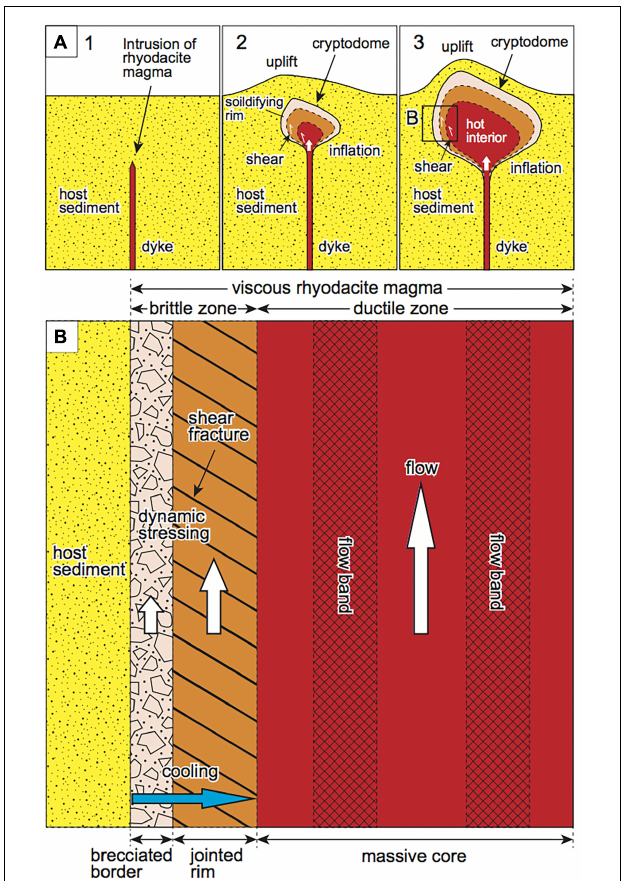
FIGURE 11 | (A) Schematic model of the growth of the Ogariyama dome, which has an asymmetric morphology. Internal inflation and marginal shear occurred simultaneously during dome growth. The location of the region shown in (B) is indicated by the rectangle. (B) Schematic model of the formation of the massive core, jointed rim, and brecciated border of the Ogariyama dome. The jointed rim and brecciated border formed in response to cooling–contraction and dynamic stress in a brittle